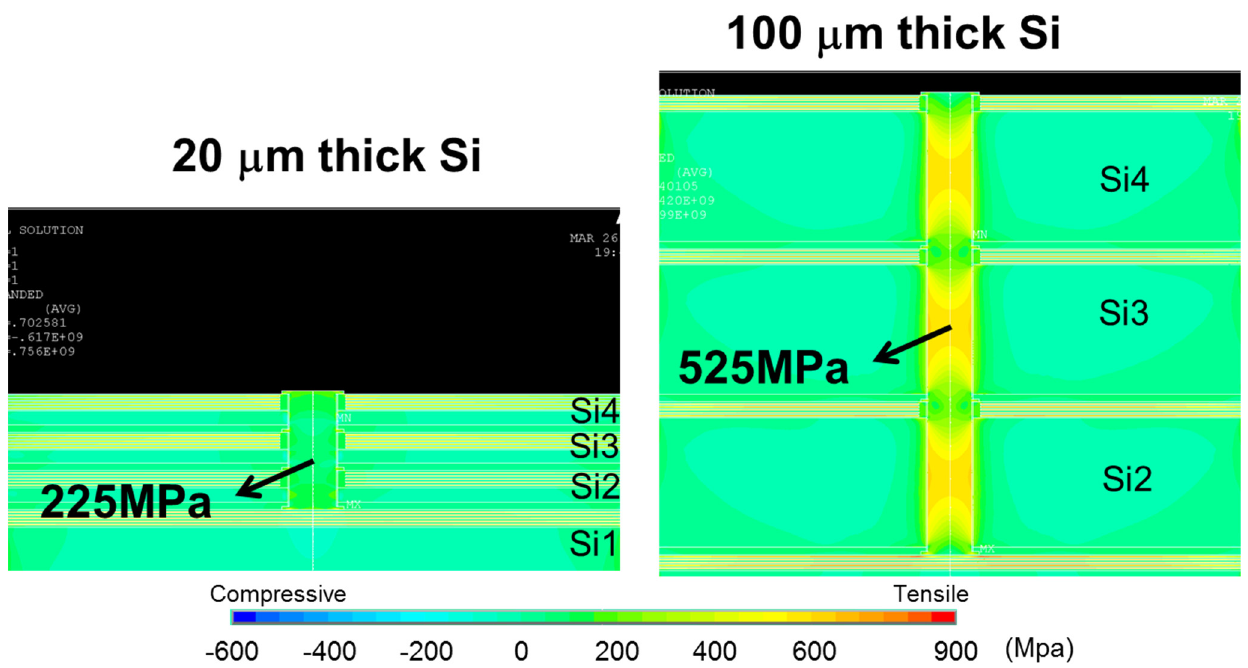
Figure 12. Stress simulation of Cu TSV using the FEM for a Si thicknesses of 100 µ m ( right ) and 20 µ m ( left ) after three wafers stacking. TSV diameter is 30 µ m. A 10 µ m Cu/low-k BEOL layer is formed on every wafer surface, and thus the depths of the TSVs are 110 µ m and 30 µ m, respectively.